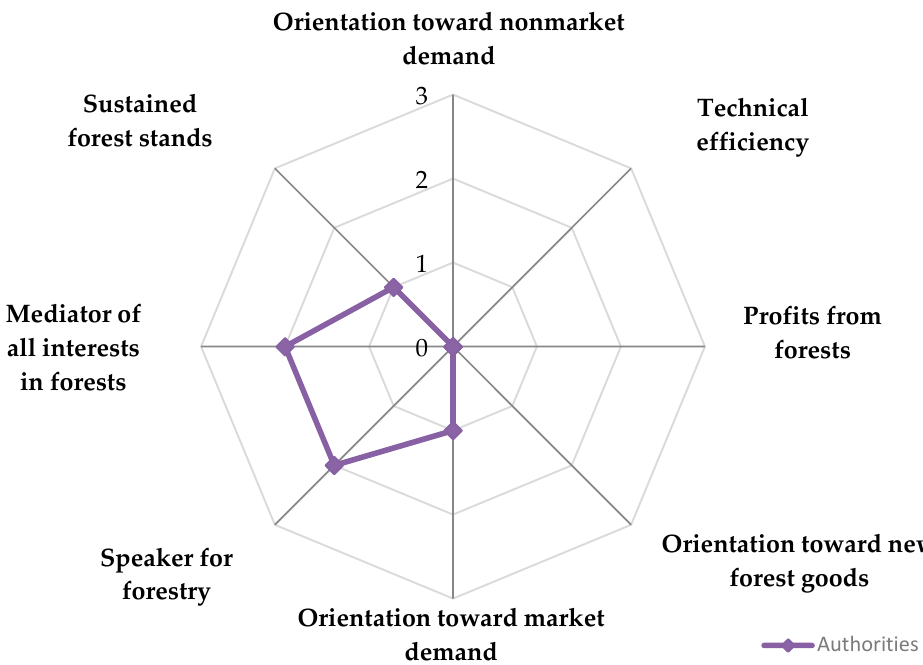
Figure 3. Performance of forest institutions with authority tasks in Republic of Moldova: (0) for no performance, (1) for weak performance, (2) for moderate performance and (3) for strong perfor- mance.